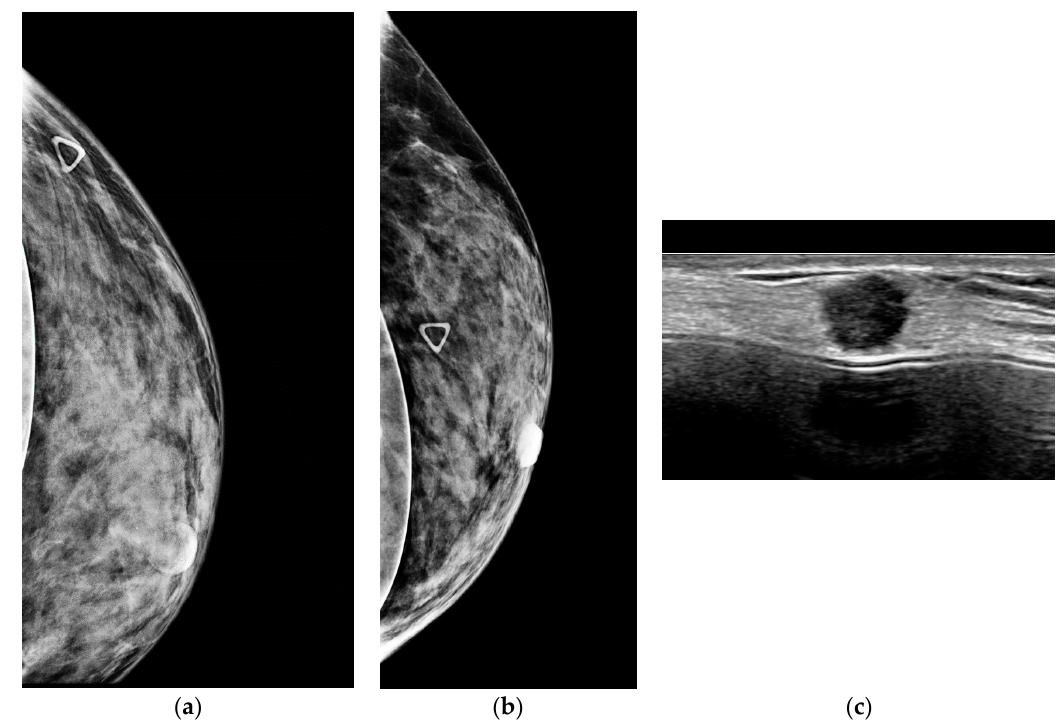
Figure 3. A 53-year-old woman with dense breasts and a palpable abnormality presents for evaluation. ( a , b ) Implant displaced CC and ML digital mammograms fail to reveal a mass (triangle denotes palpable abnormality). ( c ) High resolution handheld ultrasound easily depicts a 0.9 cm spiculated mass due to invasive ductal carcinoma.